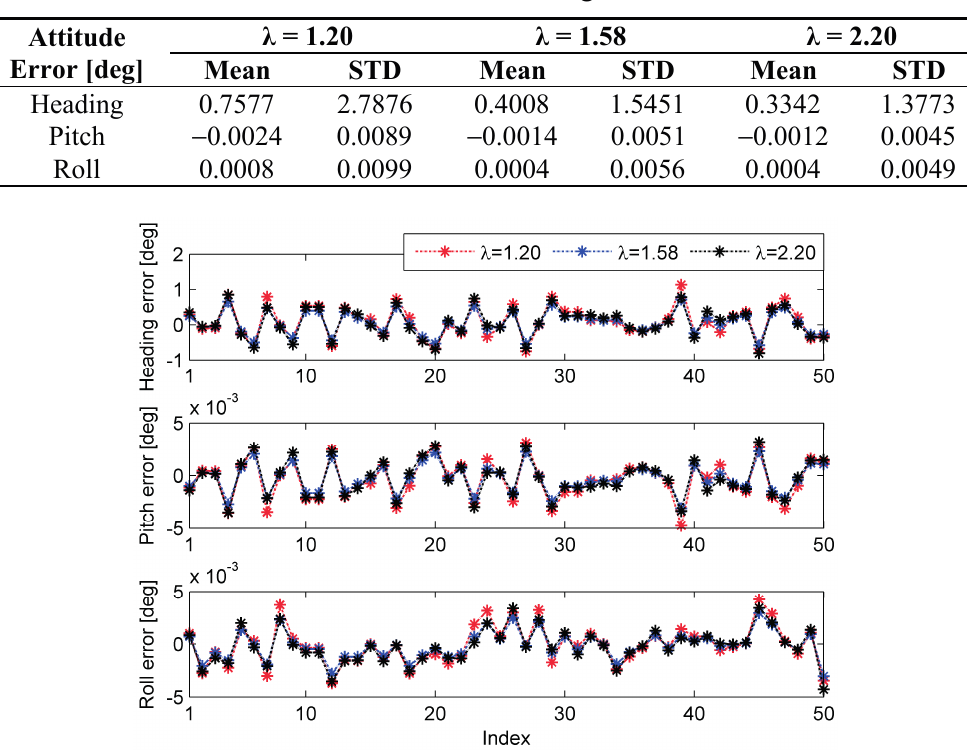
Figure 4. Attitude errors of the 50 simulations for Algorithm 1. Table 12. Statistics for Algorithm 1.